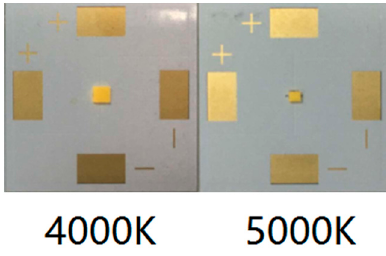
Figure 2. Illustration of the test samples. Table 1. Information of the CSP LED